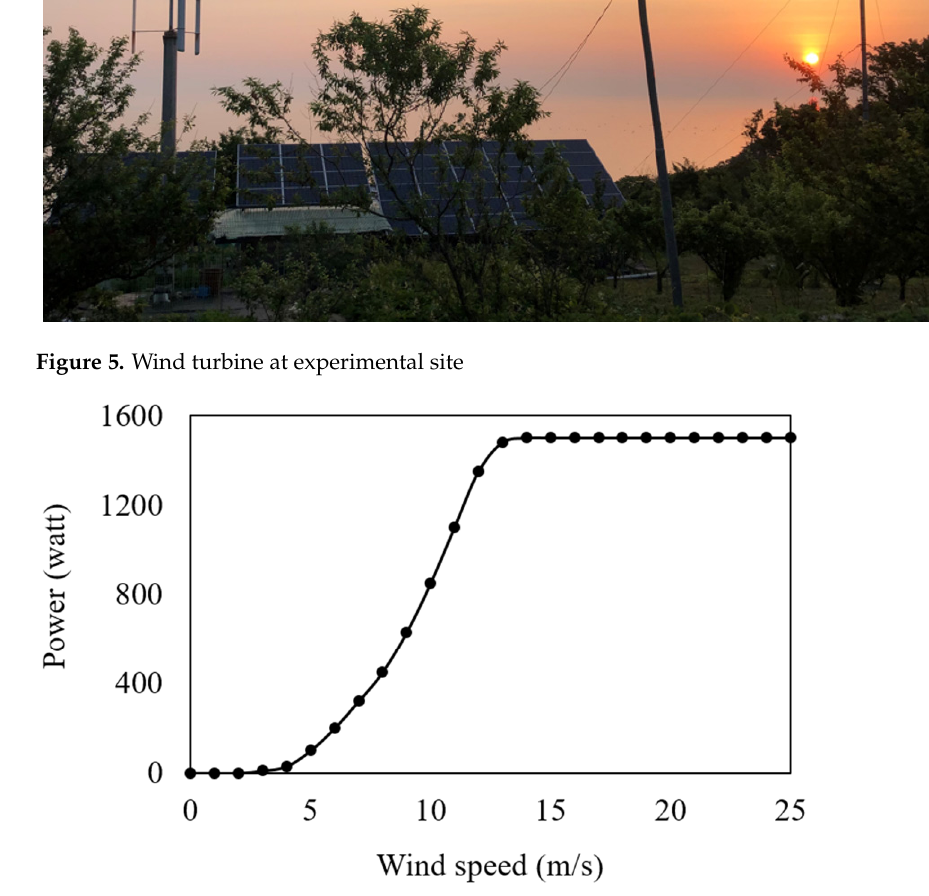
Figure 6. Power curve of wind turbine installed at experimental site [17].